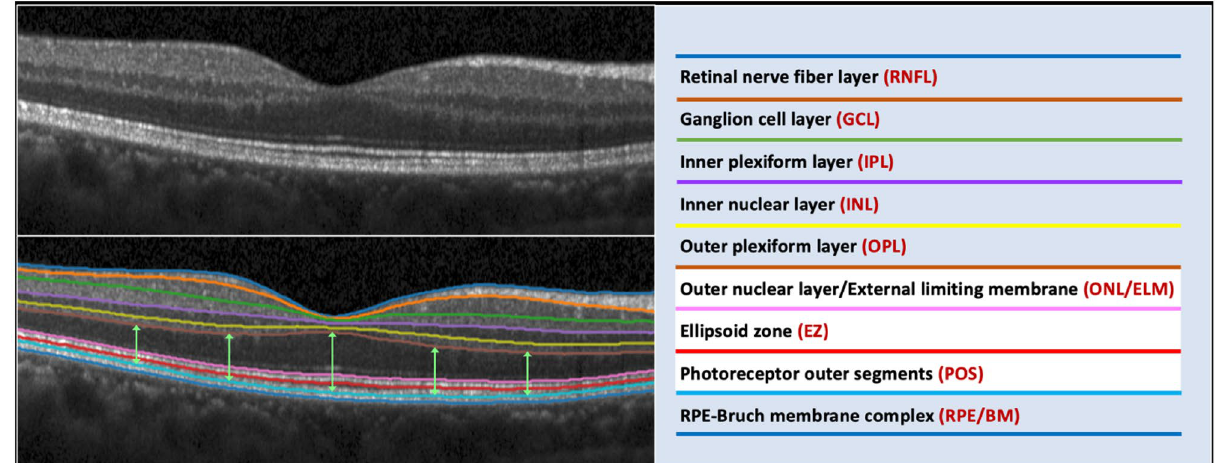
Figure 1. Graph showing the automatic delineation of the nine retinal layers and bands by optical coherence tomography and a deep learning and an interior point method-based algorithm. Nine layers of the retina were segmented, included the retinal nerve fiber layer (RNFL), the ganglion cell layer (GCL), the inner plexiform layer (IPL), the inner nuclear layer (INL), the outer plexiform layer (OPL), the outer nuclear layer/external limiting membrane (ONL/ELM), the ellipsoid zone (EZ), the photoreceptor outer segments band (POS), and the retinal pigment epithelium-Bruch membrane (RPE/BM). The current study focused on the photoreceptor layer, which was composed of three structures, including ONL, EZ and POS, shown as arrow (left figure), and the zones in white background (right